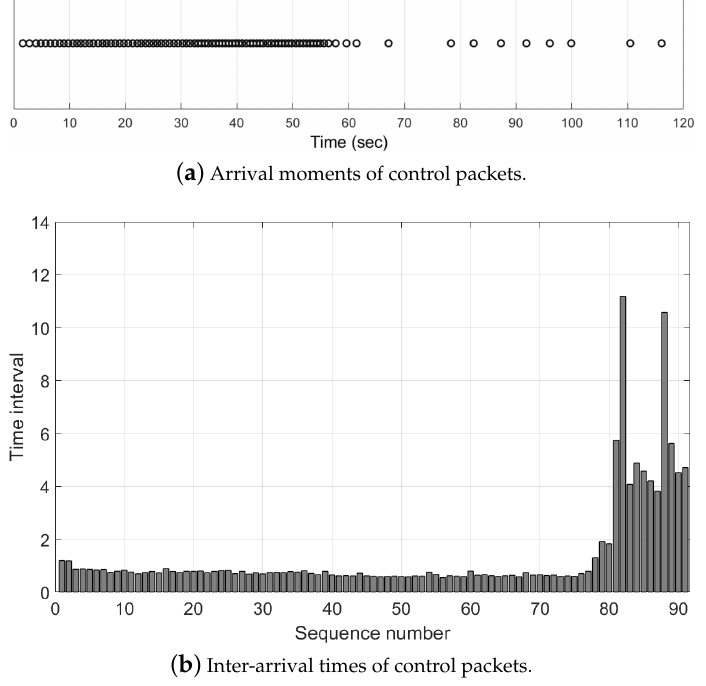
Figure 10. The limitation of existing system in the problem situation.